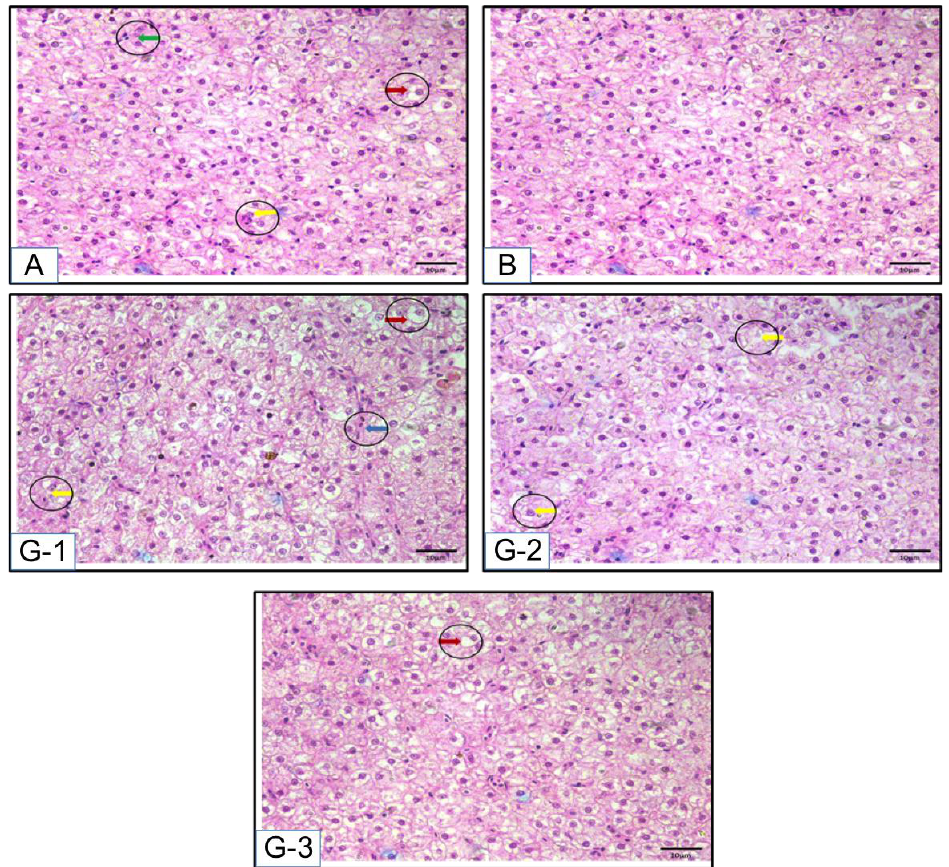
Figure 3. Photomicrographs (400×) of livers of the common carp ( C. carpio ) experimentally exposed for 28 days to CuO NPs (1.50 mg/L) as positive control ( A ; C-positive group), to no treatments as negative control ( B ; C-negative group), and to different concentrations of the fenugreek ( T. foenum- graecum ) extract at 100 mg/L ( G-1 ), 125 mg/L ( G-2 ), and 150 mg/L ( G-3 ). Fish livers from the positive control showed various histological aberrations including vacuolization (red arrow), degenerative hepatocytes (yellow arrow), dilated sinusoid (blue arrow), and complete degeneration (green ar- row). Fish from groups treated with the fenugreek showed dose-dependent curative effects in their livers. The scale bar represents 10 µm; five fields of one histological section per sample were ana-